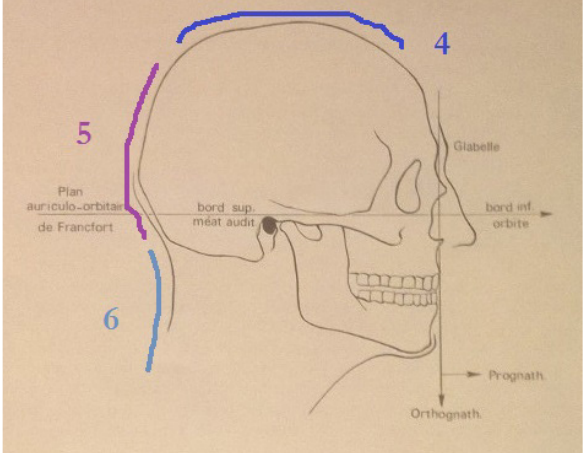
Figure 4. Points of variation for the head (from Pales, 1976).